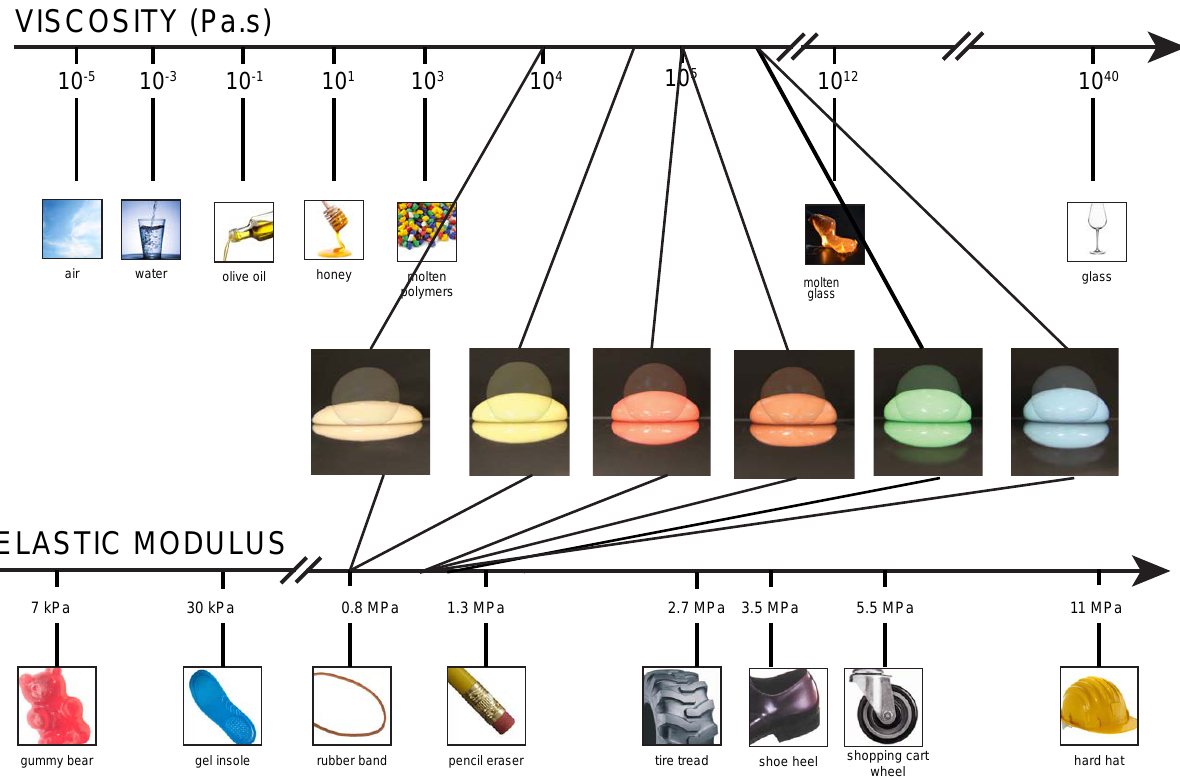
Figure A5: Low-dimensional descriptions of complex materials can help ground these materials within the frameworks for which intuition already exists. Figure adapted from [6, 7], and